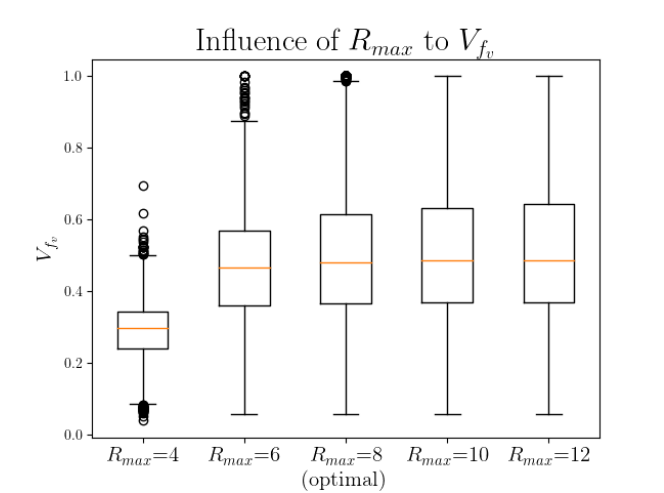
Figure 21. Variation in maximum fibre radius in relation to V f